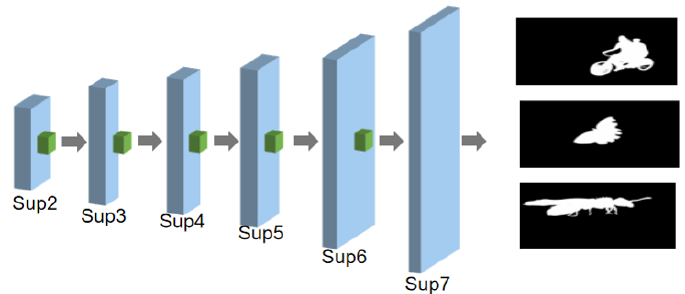
Figure 6. The devised architecture of the feature decoder module.